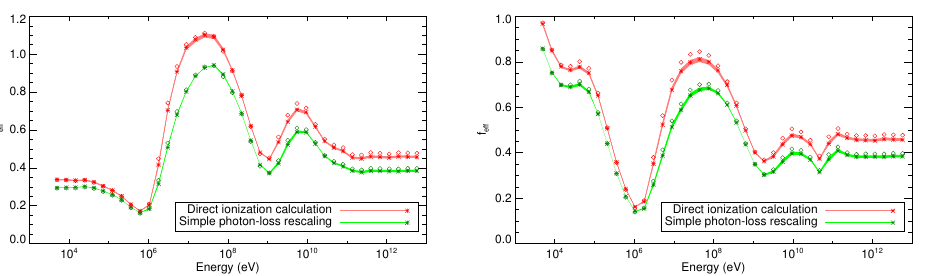
Figure 2: f coefficients as a function of energy for e + e − (left column) and photons eff (right column), for annihilating DM. The widths of the red and green bands indicate systematic uncertainties in the derivation of the f factors. Red and green stars in- eff dicate two different methods of calculating the efficiency factors, with the red points corresponding to the detailed calculation and the green to a simplified version. Dia- monds indicate f evaluated as the value of the efficiency of deposition at z = 600, eff rather than taking into account the full redshift dependence. Figure reproduced from Ref. [ 5 ] .